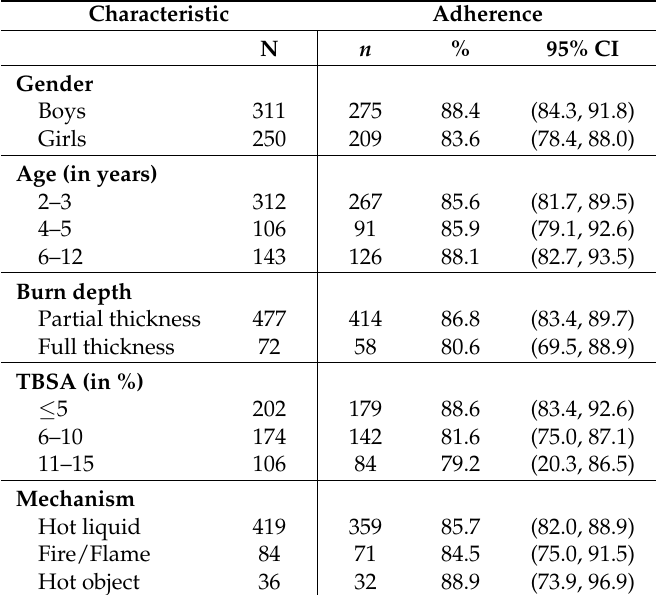
Table 4. Adherence to the referral guidelines by patient and burn characteristics for children ≥ 2 years of age ( n = 561).